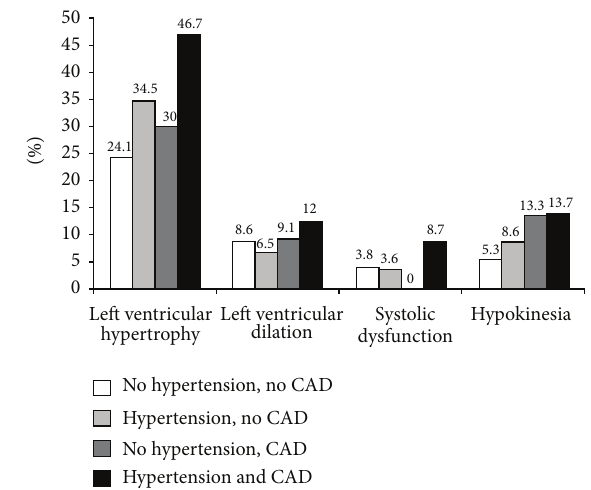
Figure 1: Prevalence of cardiac echographic disorders according to the presence of coronary artery disease (CAD) and/or